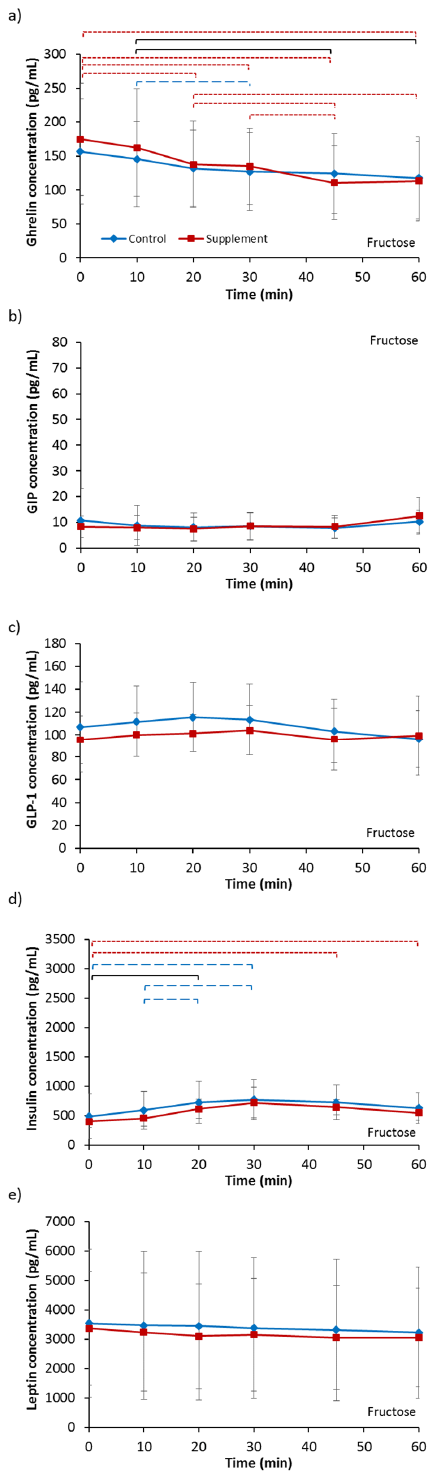
Figure 2. Serum concentrations of ( a ) ghrelin; ( b ) glucose-dependent insulinotropic polypeptide (GIP); ( c ) glucagon-like peptide-1 (GLP-1); ( d ) insulin and ( e ) leptin for 60 min following ingestion of a 6% fructose solution. Treatments were control without fructose supplementation and with three days of supplementation with 120 g fructose per day. Brackets denote significant difference between time-points, blue long dashed for control trial only, red small dashed for supplement trial only and black solid for both trials ( p < 0.05). Values are mean ± standard deviation.